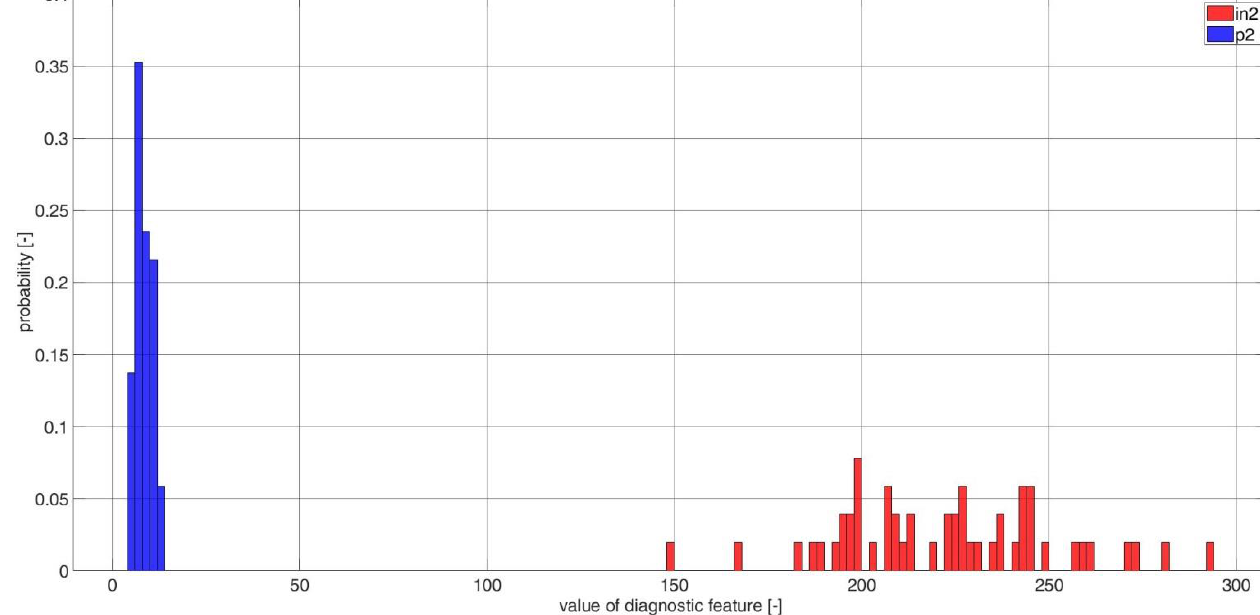
Figure 7. Histograms of the diagnostic features, based on the CCSM3 (correlation number is 23 — Table A1) bearings in2 and p2.